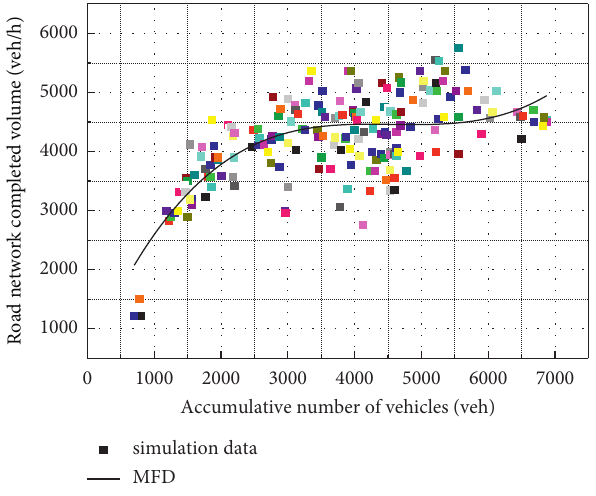
Figure 2: Simulation road network MFD.